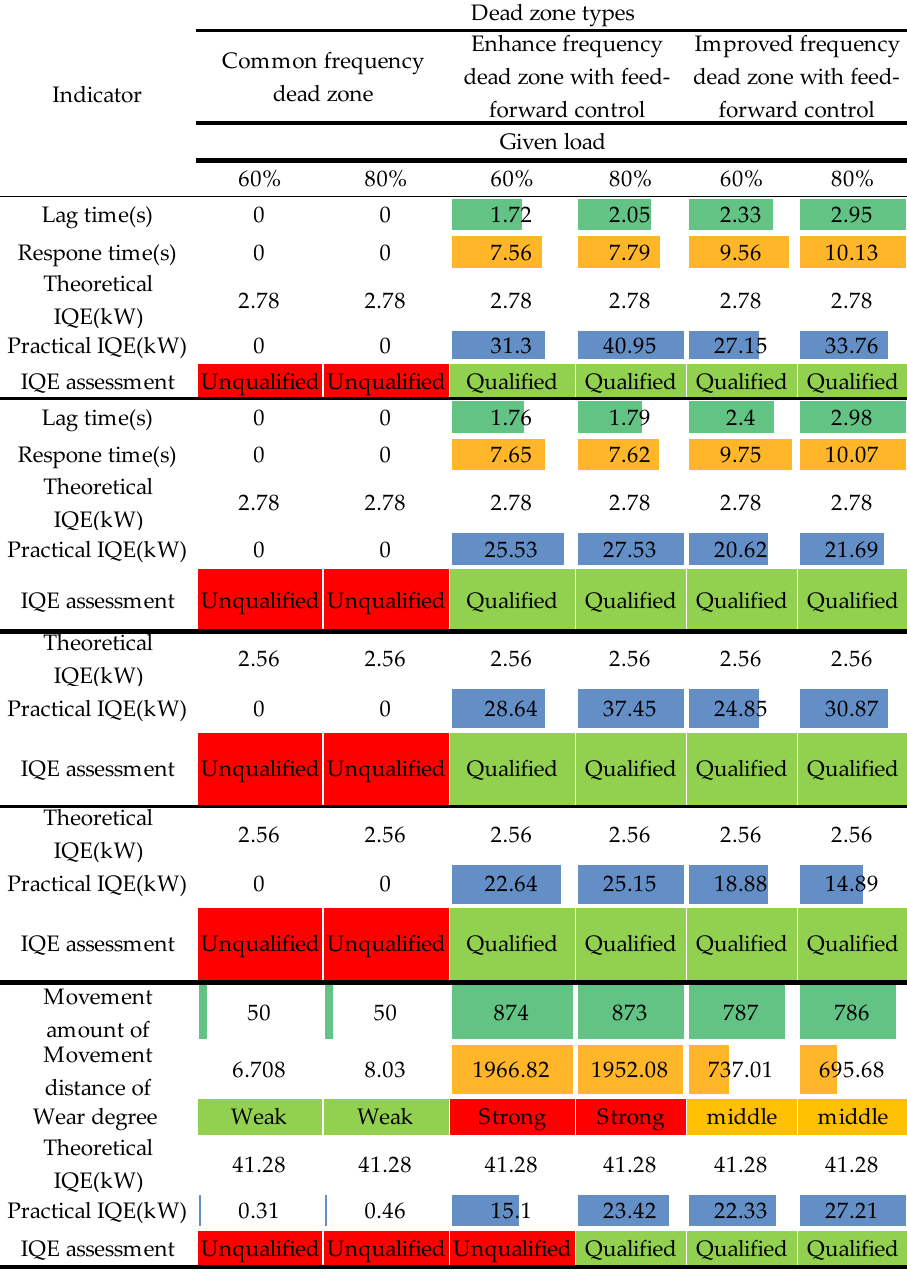
Figure 20. PFC Indicators for Different Frequency Dead Zones. * IQE = integral quantity of electricity.